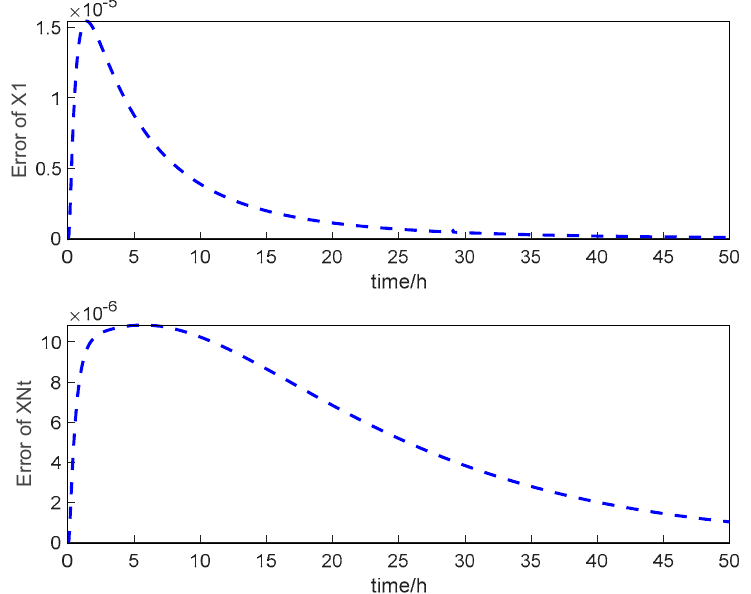
Figure 8. Dynamic tracking error of concentration at the top and bottom of the column when Z f +10%.